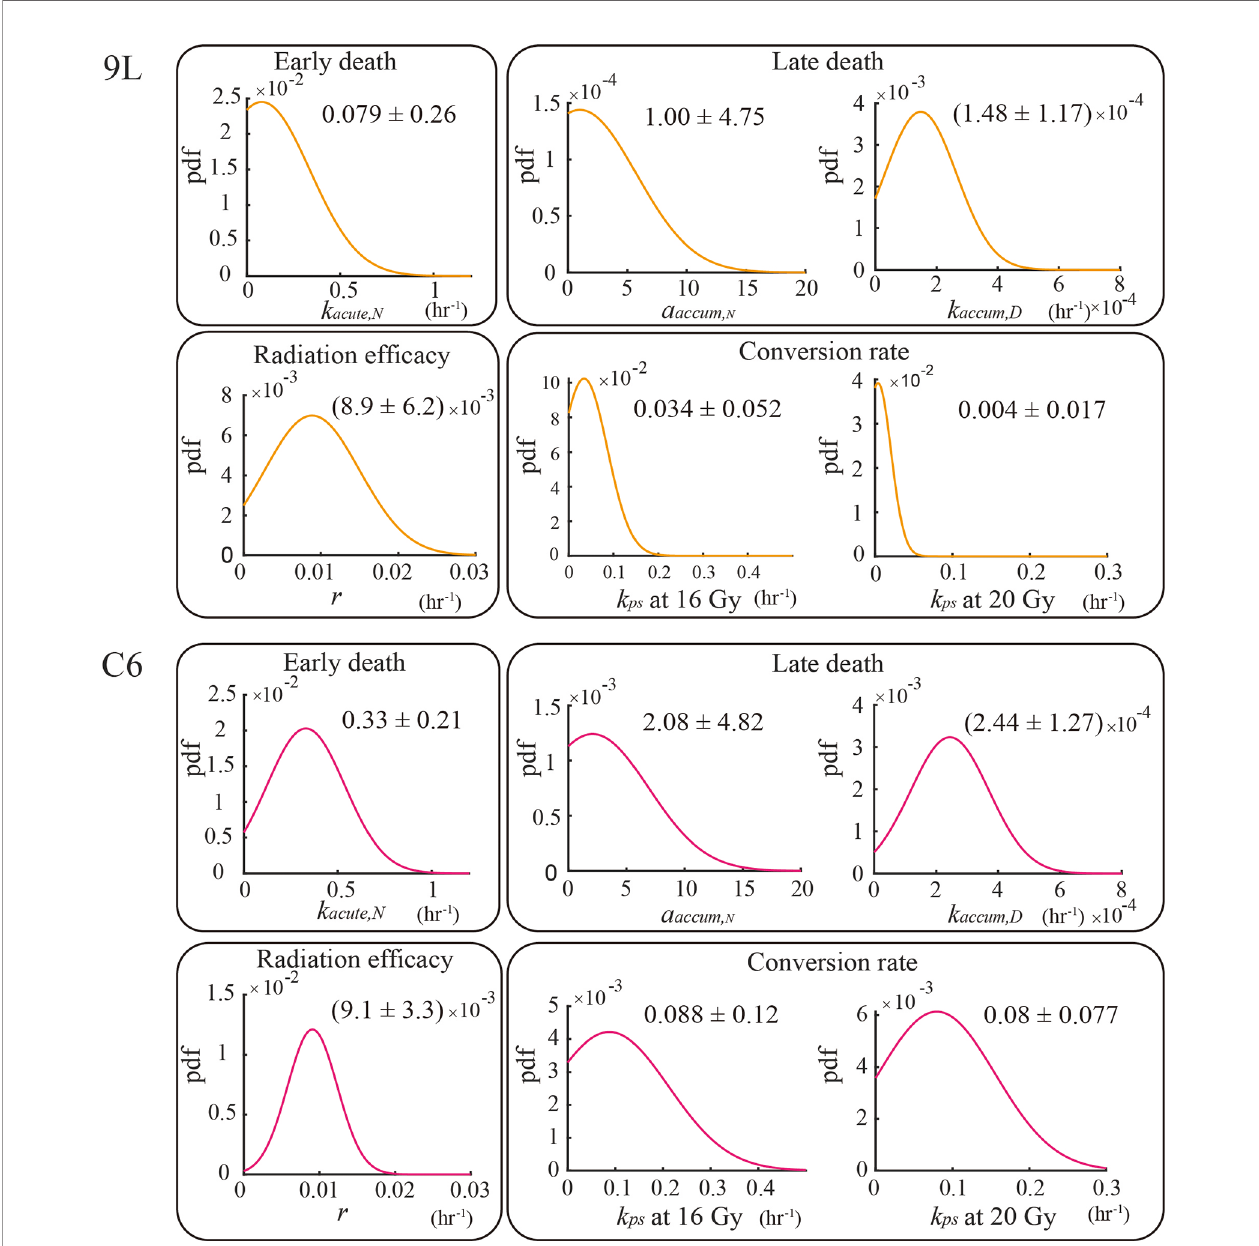
FIGURE 5 | Parameter calibration results. All parameters are fi t globally using the training set and are independent of initial seeding density or dose schedules (e.g., the four fractions of 4 Gy curves share the same set of parameters as the two fractions of 10 Gy curves for both the 9L and C6; the one exception is for k ps , where we treat k ps (16 Gy) and k ps (20 Gy) as two individual parameters. The biological interpretation of the parameters requires that these parameters must take on a value great than or equal to 0; thus, the lower bound of the parameters is set to zero during